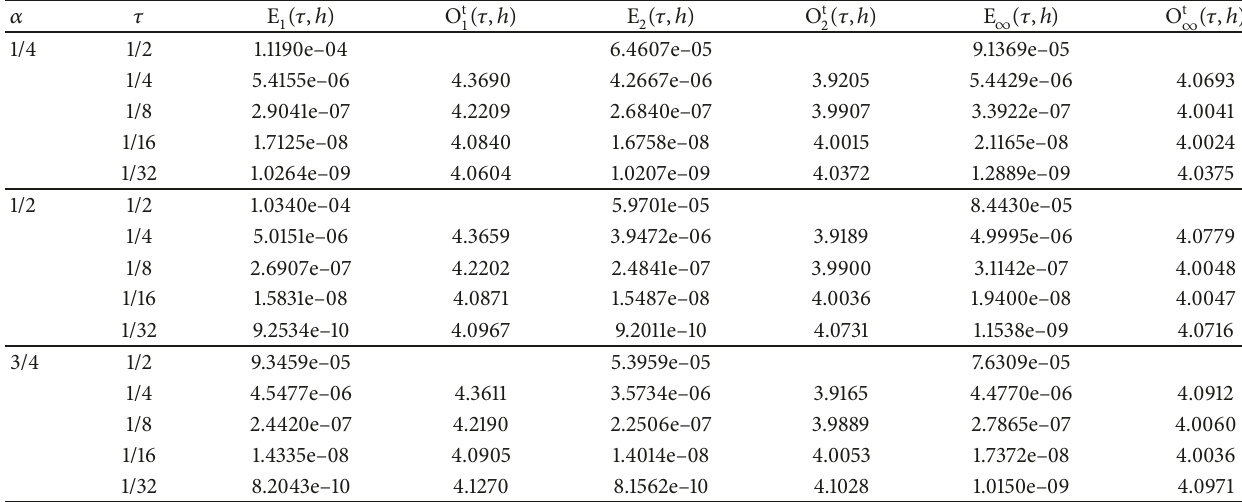
Table 2: The errors and the spatial convergence orders of the compact difference scheme (23) for Example 1 (ℎ = 1/10000) .